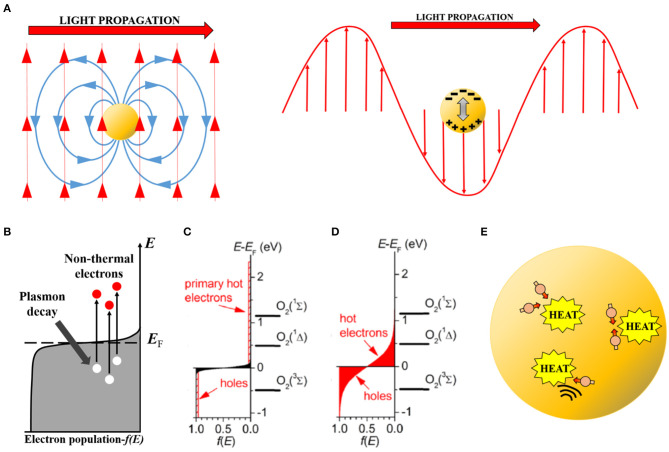
Conceptual scheme showing the different steps in the induction and decay of a plasmon excited in a metal nanoparticle. (A) Left, initial electromagnetic induction of an electric field (blue) by the impinging optical electromagnetic field (red). Right, induced internal dipole (plasmon) in the nanoparticle by the optical field (note negative and positive induced charges). (B) Non-thermal electron excitation by plasmon decay. Electrons (red circles) are pumped to high energy levels leaving behind holes (white circles). (C) Initial population of non-thermal electrons in an intensively excited (by pulsed laser) nanoparticle. Note that electrons reach energies of 2.5 eV and left behind holes of equal energetic magnitude. Molecular oxygen electronic levels have been included on the energy axis for comparison. (D) Hot-electron (-hole) populations (red zones) after non-thermal electron (-hole) scattering. Electrons and holes are more abundant than in (C) and their energies are still large (up to 1 eV). The first excited state O2 (1Δ) of molecular oxygen can be efficiently induced under this condition. (C,D) Reproduced with permission from Chadwick et al. (2016). (E) Hot electrons (dull red circles) and phonons (black waves) scatter, transferring their excitation energy to the nanoparticle lattice which increases its temperature and that of the environment by heat conduction.